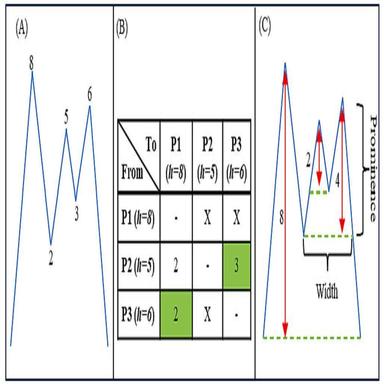
Illustration of topographic prominence: (A) heights of peaks and valleys denoted in a time series; (B) pairing of peaks with numbers indicate the lowest value between the "To" and "From" peaks. X denotes that the "To" peak is not higher than the "From" peak. Highlighted cells denote the maximum value of that row; (C) the processed time series will all prominences denoted.